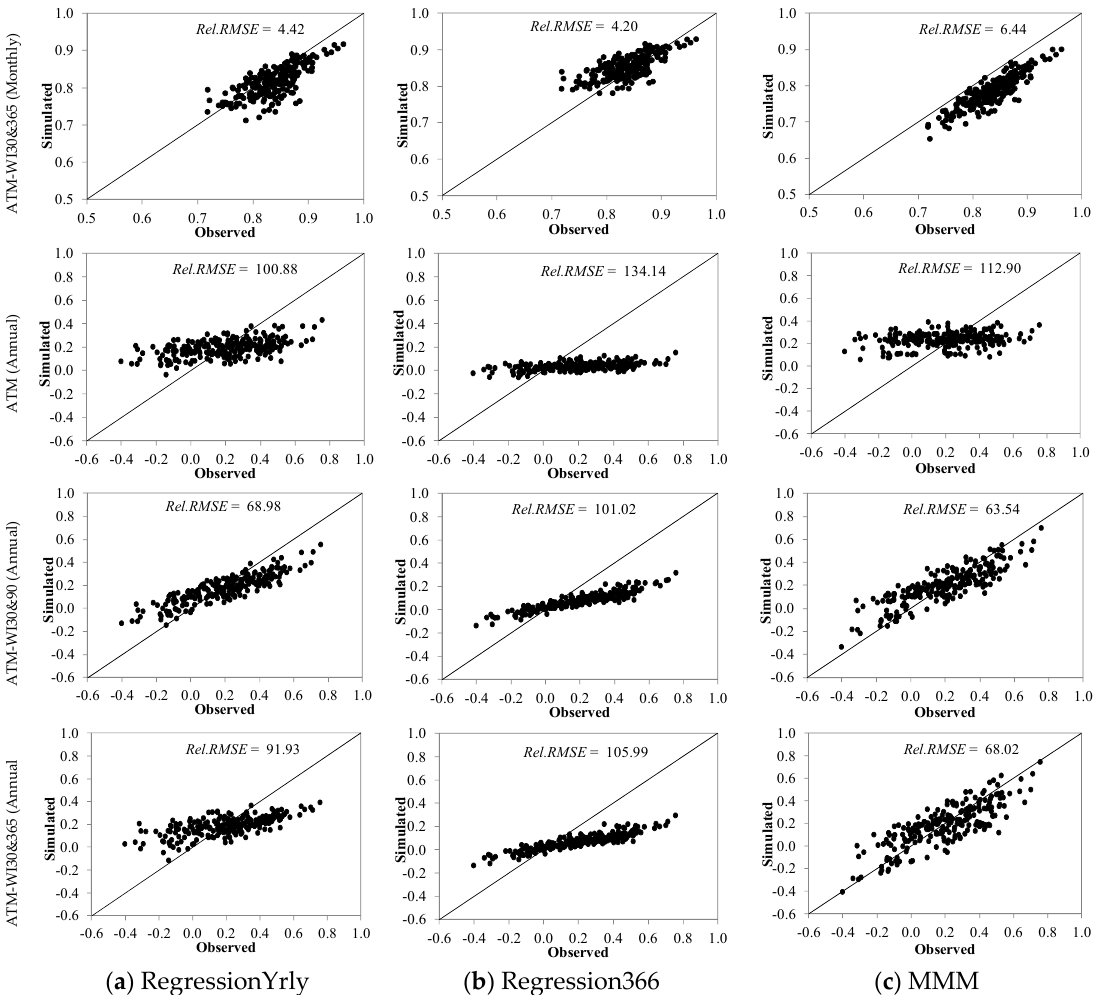
Figure 7. Scatter plots of observed and models simulated daily, monthly and annual cross correlations using single site model (Calibration period). Rel. RMSE values are shown on the top right of each plot: ( a ) using RegressionYrly model; ( b ) using Regression366 model; and ( c ) using MMM.